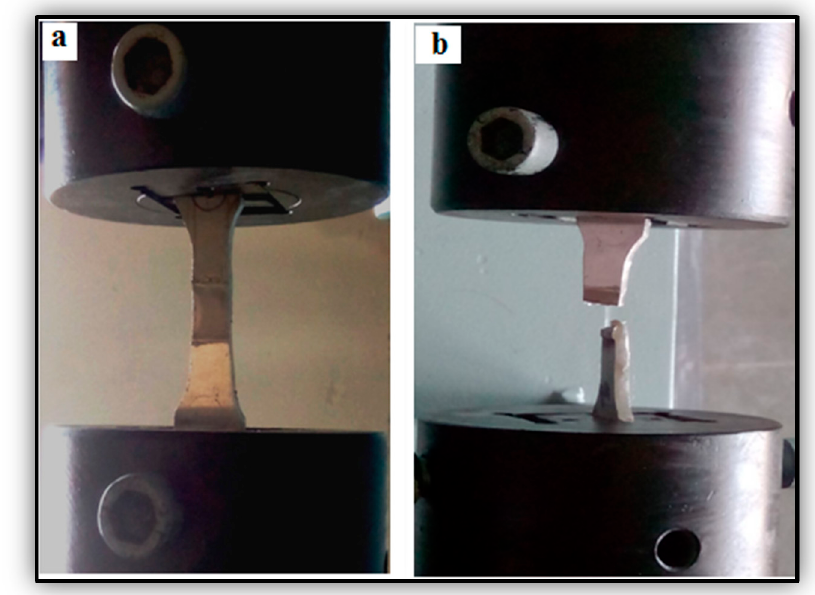
Figure 3. Image of tensile test ( a ) before fracture, ( b ) after fracture.